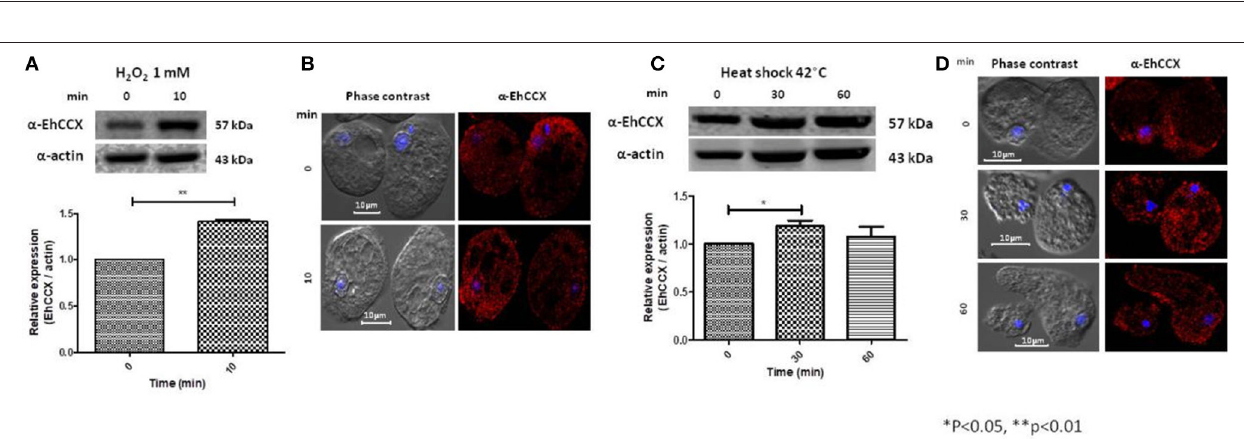
FIGURE 6 | Expression and localization of CCX in E. dispar . (A) The comparison of the expression level of the CCX protein in E. histolytica (EhCCX) and E. dispar (EdCCX) was performed by Western blot using the α -EhCCX antibody. As an internal control, the membranes were probed with an α -actin antibody. The band detected by the α -EhCCX antibody was analyzed by densitometry and the data were normalized to the actin content. The relative expression in E. histolytica was taken as 1. Data are expressed as the mean ± standard error of three independent experiments. (B) E. histolytica and E. dispar trophozoites were fixed, permeabilized and incubated with α -EhCCX antibodies. Next, they were incubated with Alexa 555-conjugated secondary antibodies, nuclei were stained with DAPI, and samples were analyzed by confocal microscopy.